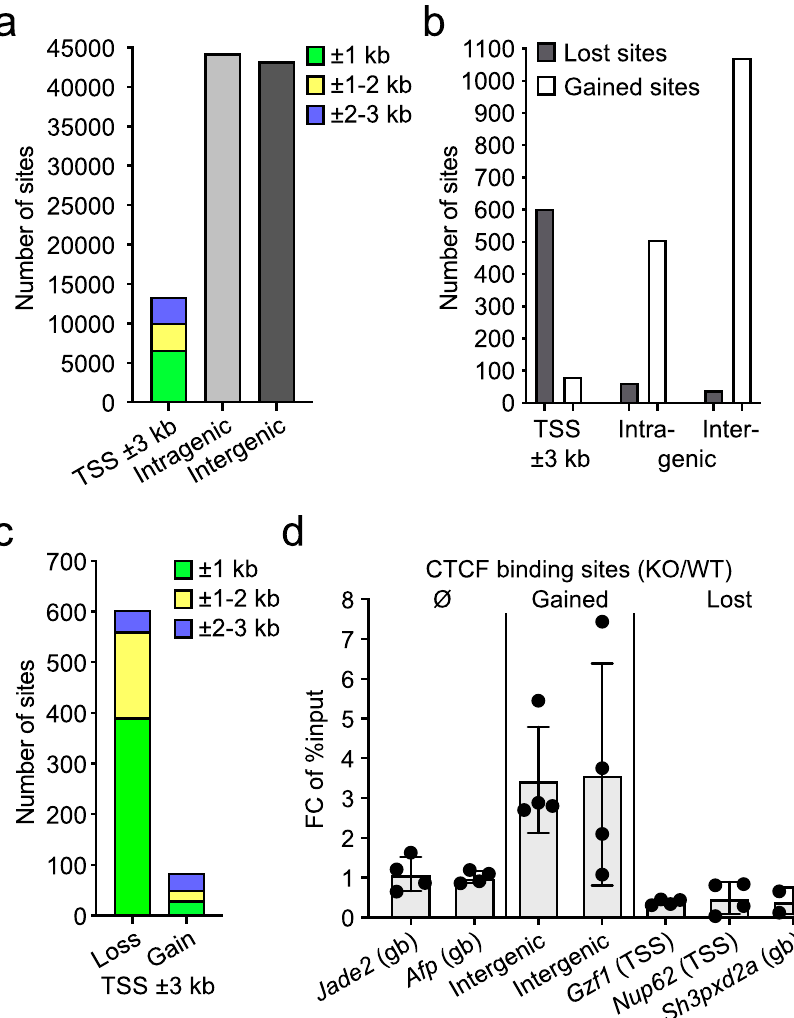
Figure 4. The accessibility of CTCF binding sites is altered in response to Ash2l loss. ( a ) ChIP-seq analysis of KO2 cells (2 replicates) treated for 7 days ± HOT. All detected CTCF binding sites in -HOT and + HOT treated cells were grouped to promoter (TSS ± 3000 bp), intragenic and intergenic regions. ( b ) Lost and gained CTCF binding sites as defined after differential analysis using Deseq2 (q < 0.05; logFC > 1) of the three regions indicated as in panel ( a ). ( c ) Lost and gained CTCF peaks near the TSS. The region is divided into three intervals on both sides of the TSS, until 1 kb, from 1–2 kb and from 2–3 kb. ( d ) CTCF ChIP-qPCR of loci that gained or lost binding or were unaffected. The relevant genes are indicated. The intergenic sites (left) are on chromosome 8 (Chr8:3,955,70-3,956,485) and on 12 (Chr12: 89,947,682-89,948,082) (left and right bar,